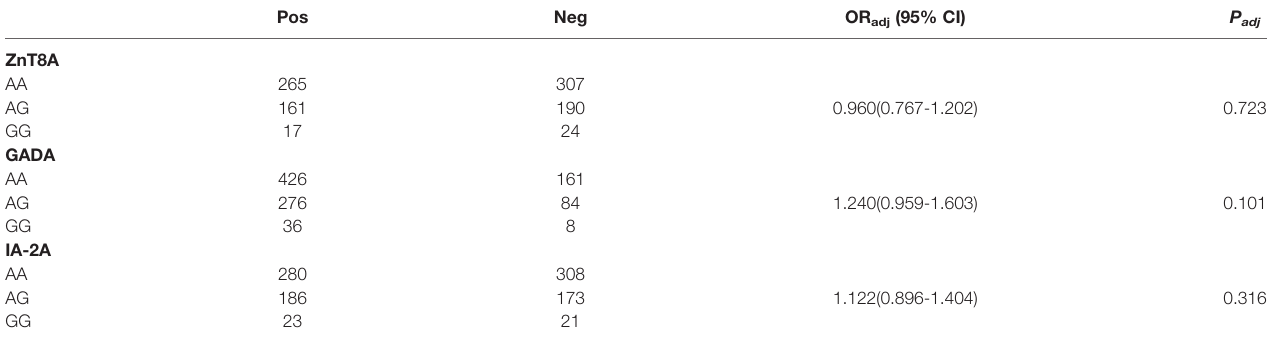
TABLE 4 | The association between the JAZF1 rs864745 A>G variant and T1D risk strati fi ed by islet autoantibody